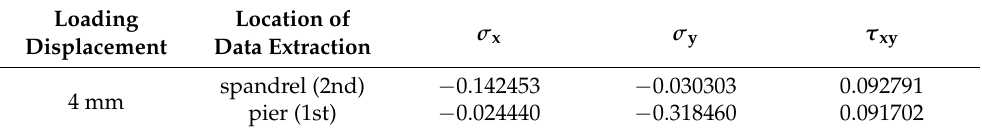
Table 1. Relevant data in reference [23]